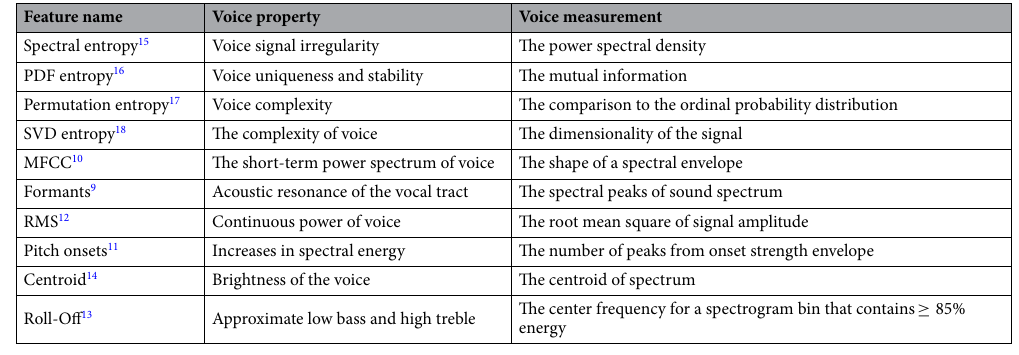
Table 1. List of critical voice fundamental